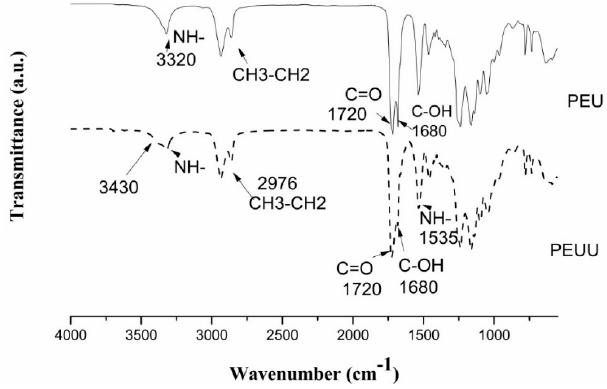
Figure 1 . FT-IR spectra of PEUs and PEUUs. Figure 1. FT-IR spectra of PEUs and